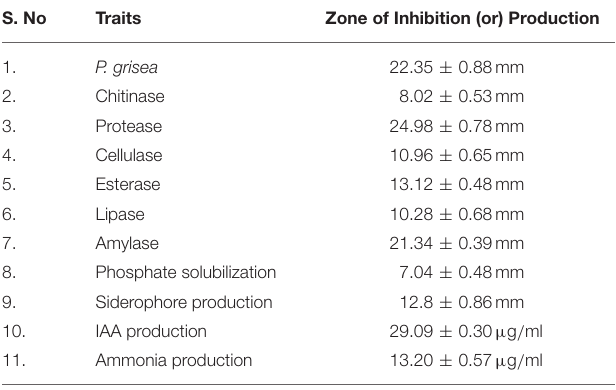
TABLE 2 | Biocontrol and plant growth promoting traits of Pseudomonas sp. MSSRFD41.